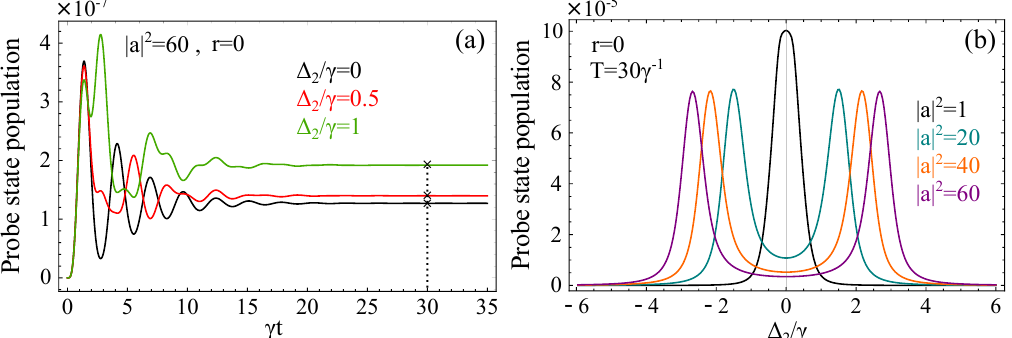
Figure 3. ( a ) Population of the probe state | b (cid:105) as a function of the time for various detunings ∆ 2 . The parameters of the strong field are: | a | 2 = 60, r = 0.5, g 1 = 0.7 γ , and ∆ 1 = 0. The vertical dashed line corresponds to the time T = 30 γ − 1 where the system is well within its steady-state regime. ( b ) Population of the probe state | b (cid:105) as a function of ∆ 2 for various values of | a | 2 . The chosen parameters are: r = 0.5, g 1 = 0.7 γ , and ∆ 1 =